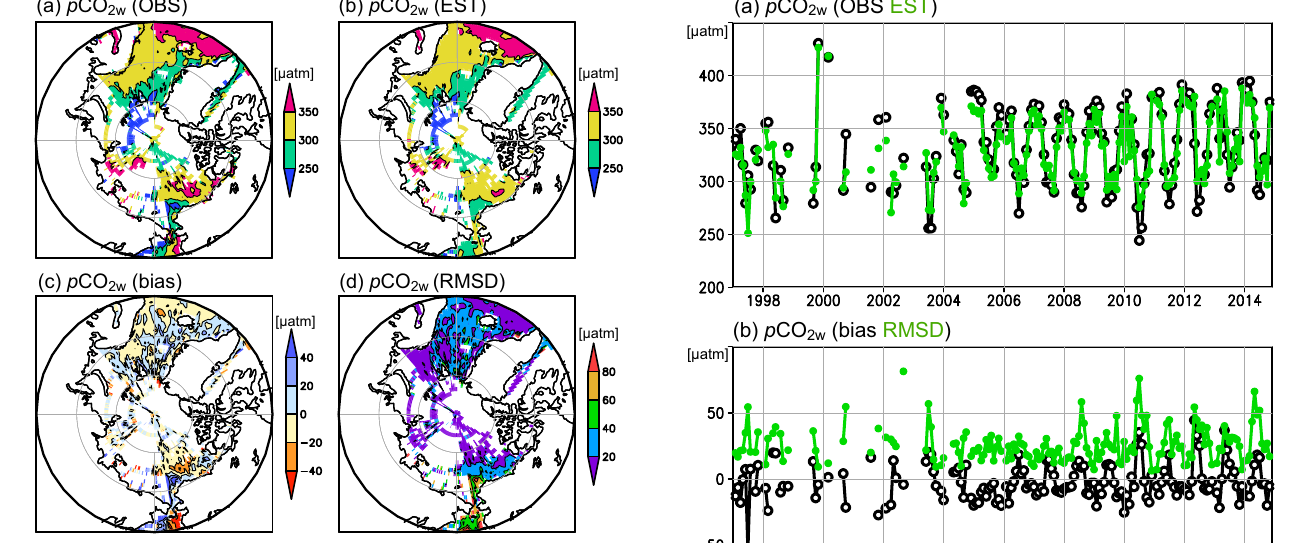
Figure 4. (a) Observed p CO 2w averaged over the whole analysis period (µatm). (b) Estimated p CO 2w averaged over the grid boxes in which observed p CO 2w values were available (µatm). (c) Bias (estimate–observation) and (d) RMSD between observed and esti- mated p CO 2w averaged over the whole analysis period (µatm).